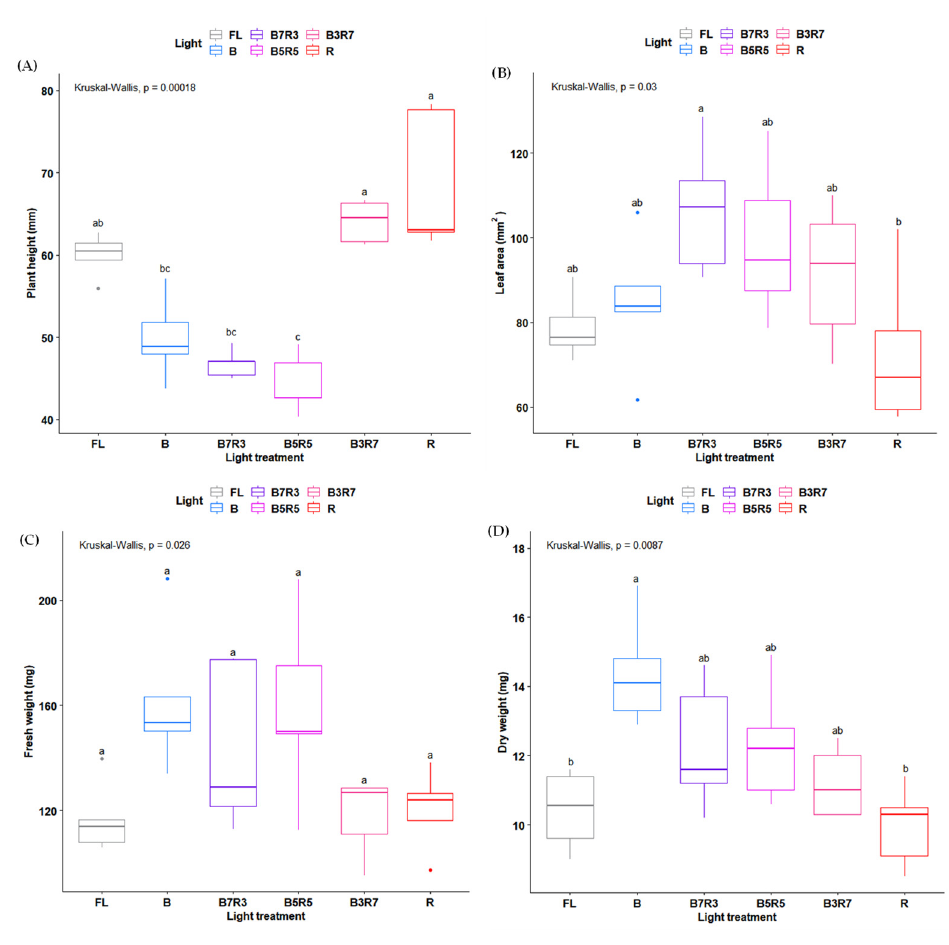
Figure 1. Growth parameters, including plant height ( A ), leaf area ( B ), fresh weight ( C ), and dry weight ( D ), of H. corymbosa in vitro after 4 weeks under different light treatments at the same PPFD of 50 μ mol·m − 2 ·s − 1 . Statistical analysis was performed with a Kruskal–Wallis test followed by a Dunn–Benjamini–Hochberg post hoc test for multiple comparisons. Different letters indicate significant differences between two medians.